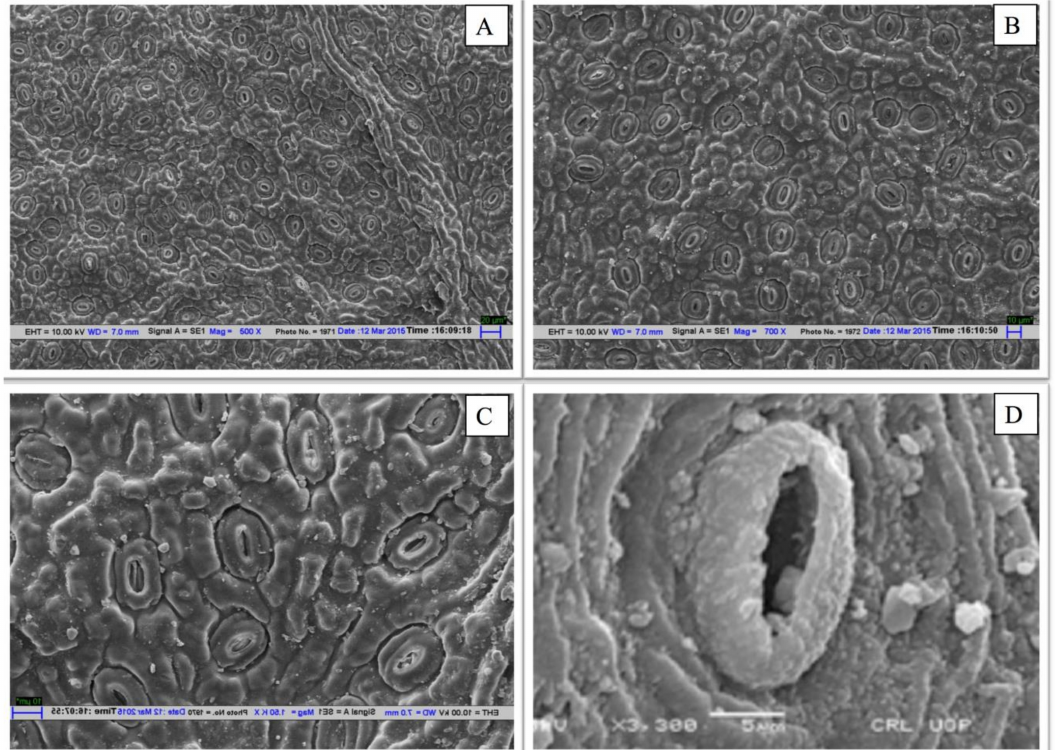
Figure 2. Leaf stomatal morphology of P. dulce as seen under SEM. ( A & B ) collection from LPS showing normal stomatal morphology. ( C & D ) collection from HPS showing stomata in deteriorated conditions with FA dust